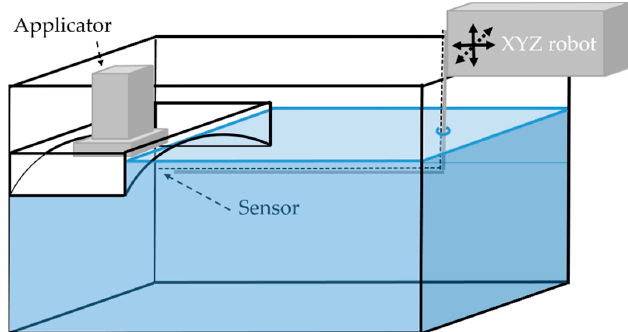
Figure 5. E-field probe measurements of the power deposition patterns were performed in a 1000 × 400 × 400 mm Plexiglas tank, filled with 80 L muscle-equivalent saline solution (0.6% NaCl). To mount